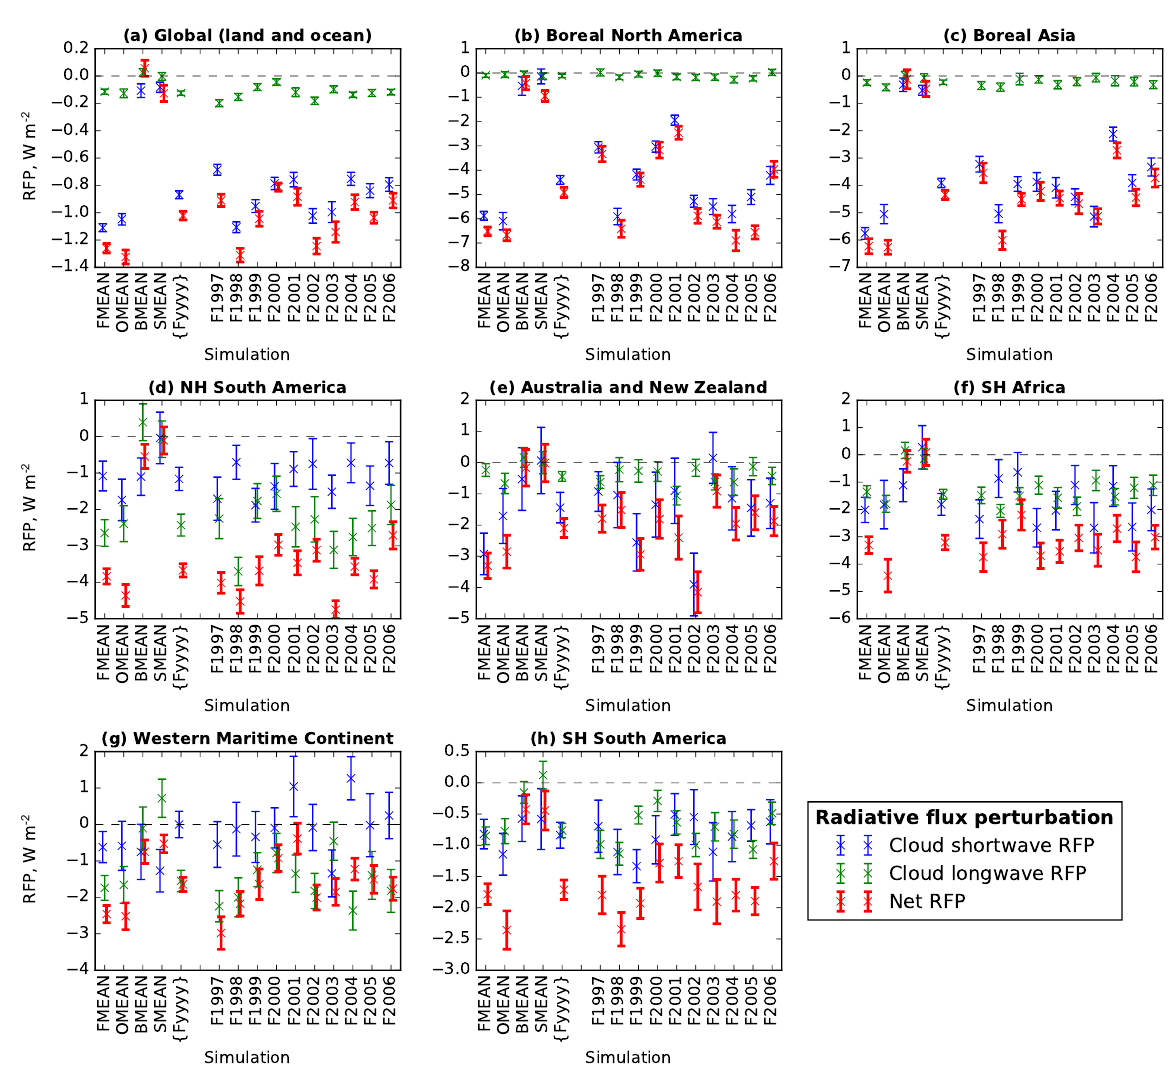
Figure 3. Cloud shortwave, cloud longwave, and net (all components, shortwave plus longwave) top-of-atmosphere radiative flux perturba- tions (RFPs) for the globe and seven regions. Results for another eight regions are shown in Fig. S6. The RFPs are relative to simulation F0 and are area-weighted. Error bars represent combined standard error, using annual regional mean data as the input – e.g. for the F1997 net RFP error bars, the combined standard error equals N F0 = 42 and N F1997 = 12 are the sample